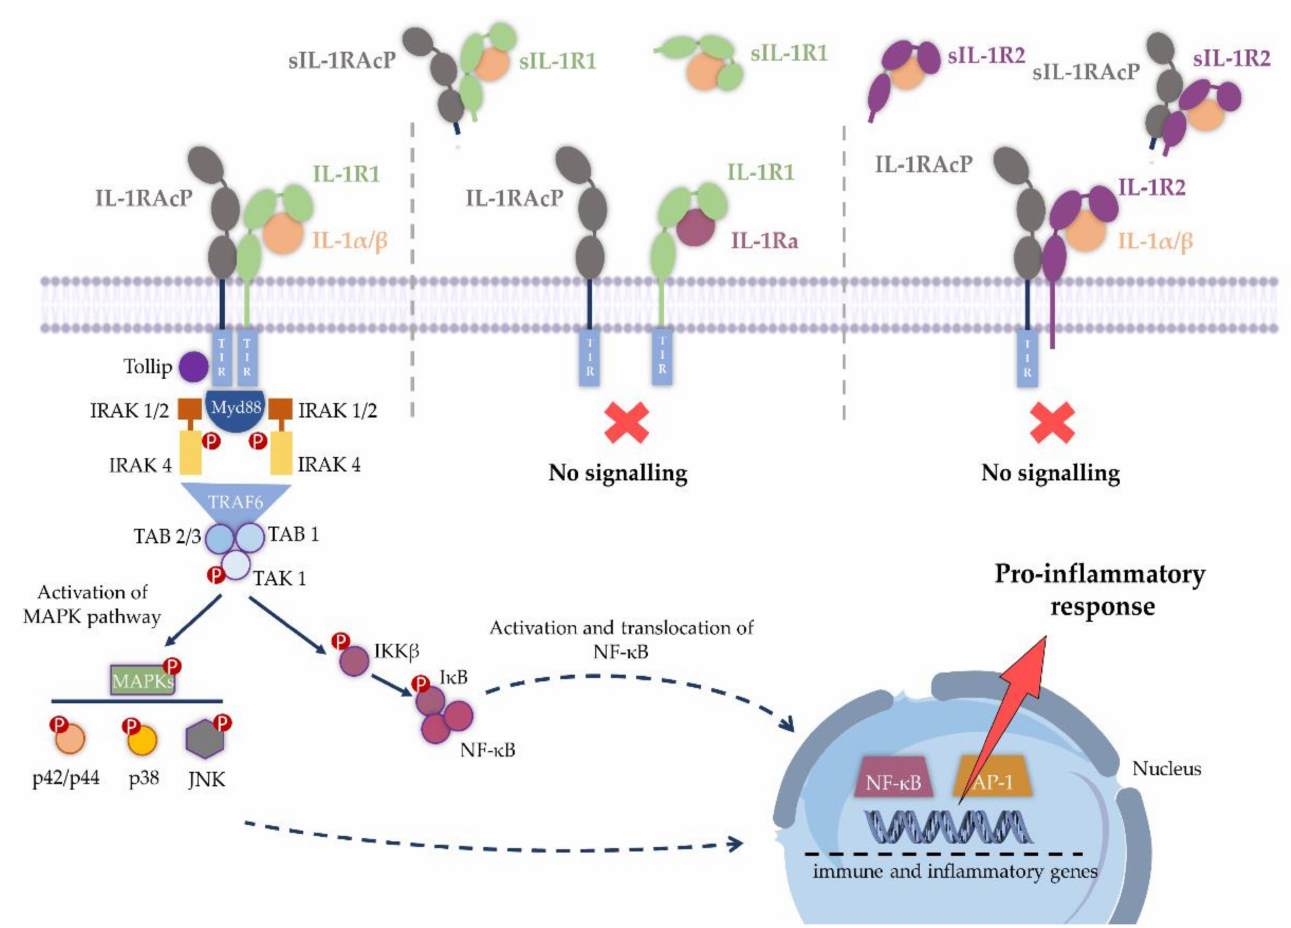
Figure 2. Schematic representation of IL-1 signaling. Upon binding of IL-1 α / β to the extracellular domain of membrane-bound receptor IL-1R1, IL-1RAcP is recruited and signaling is initiated by the interaction of the intracellular TIR domains of the two polypeptide chains. When IL-1Ra binds IL-1R1, the IL-1RAcP is not recruited, thereby blocking signaling. Similarly, when IL-1 β binds IL-1R2, no signaling occurs as IL-1R2 lacks a cytoplasmic TIR domain. IL-1 signaling may also be inhibited by soluble forms of the receptor, sIL-1R1 and sIL-1R2, lacking the transmembrane and intracellular regions of the native form, binding both IL-1 α , IL-1 β and sIL-1RAcP. Adapted from [39]. Figure abbreviations: IL-1, interleukin-1; IL-1R1, interleukin-1 receptor type 1; IL-1Ra, interleukin 1 receptor antagonist; IL-1RAcP, interleukin-1 receptor accessory protein; IL-1R2, interleukin-1 receptor type 2; TIR domain, the toll-interleukin-1 receptor homology domain; IRAK, interleukin-1 receptor- associated kinases; TRAF6, tumor necrosis factor receptor associated factor 6; TAK1, transforming growth factor- β -activated kinase 1; TAB, TAK1-binding proteins; MAPK, mitogen-activated protein kinases; p42/p44 MAPK, p42/p44 mitogen-activated protein kinases; p38 MAPK, p38 mitogen- activated protein kinases; JNK., c-Jun N-terminal kinase; IKK β , I kappa B kinase β ; NF- κ B, nuclear factor-kappa B; AP-1, activator protein